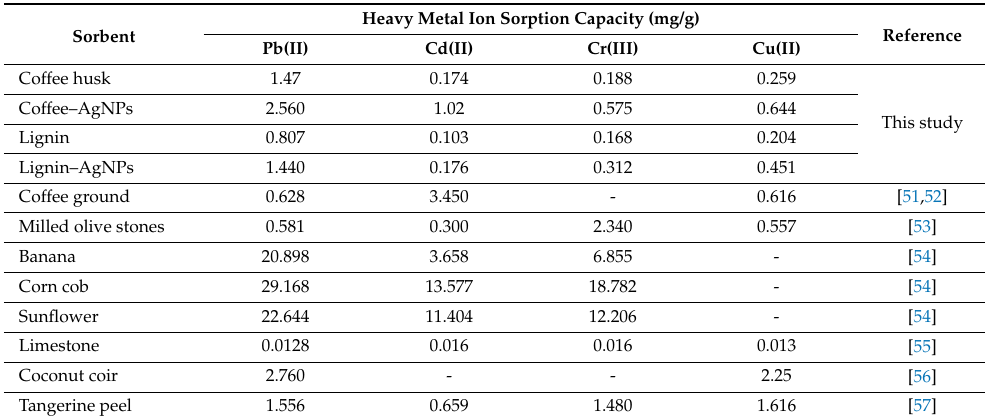
Table 1. Sorption capacity in